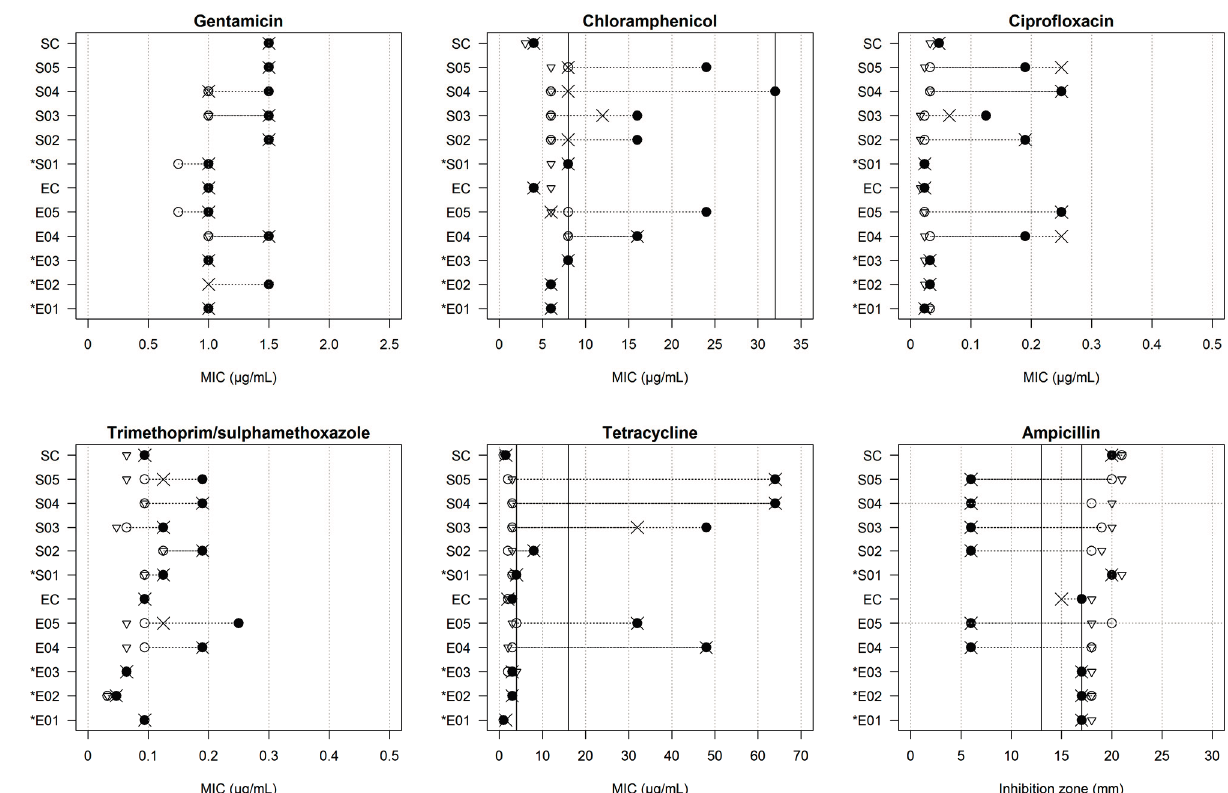
Figure 2. MIC (µg/mL) for antimicrobials of 12 strains before ( ○ ) and after ( ● ) exposure experiment; controls of adaptation experiment ( ∇ ) and after treatment with efflux pump inhibitor PA β N (x). Vertical black lines: breakpoints for susceptible (on the left), intermediate (between two lines), and resistant (on the right) classes based on Clinical and Laboratory Standard Institute (CLSI) guidelines. For ampicillin, changes in inhibition zone diameter (mm) shown, with full resistance on the left and susceptibility on the right. Breakpoints for gentamicin ( ≤ 4 µg/mL, sensitive), ciprofloxacin ( ≤ 1 µg/mL, sensitive), and trimethoprim/sulphamethoxazole ( ≤ 2 µg/mL, sensitive) not shown since outside the range. * Strains did not increase MIC for Product